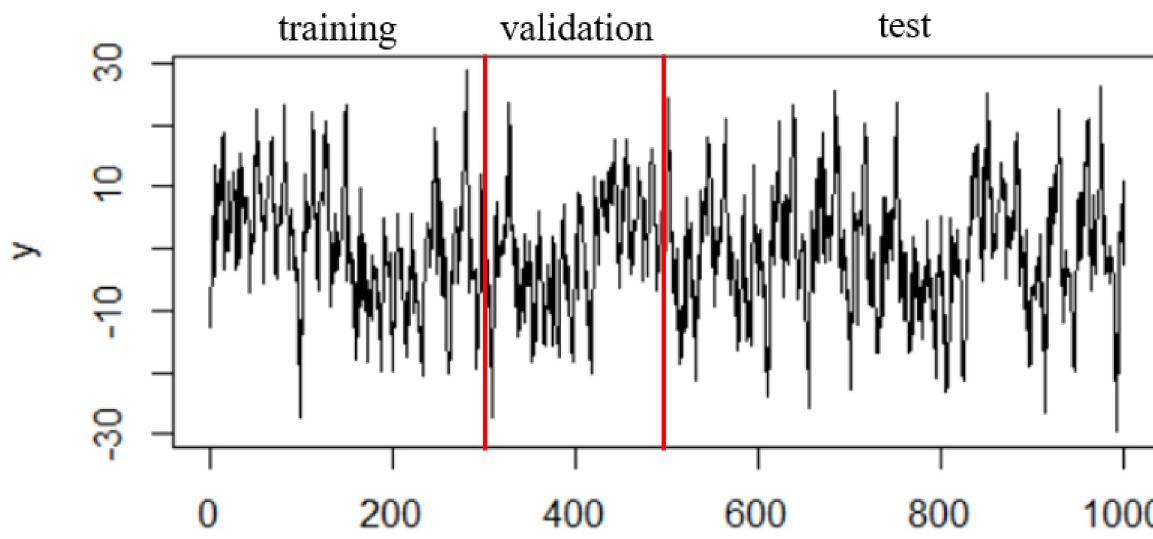
Fig 8. Time series simulated by Lorenz